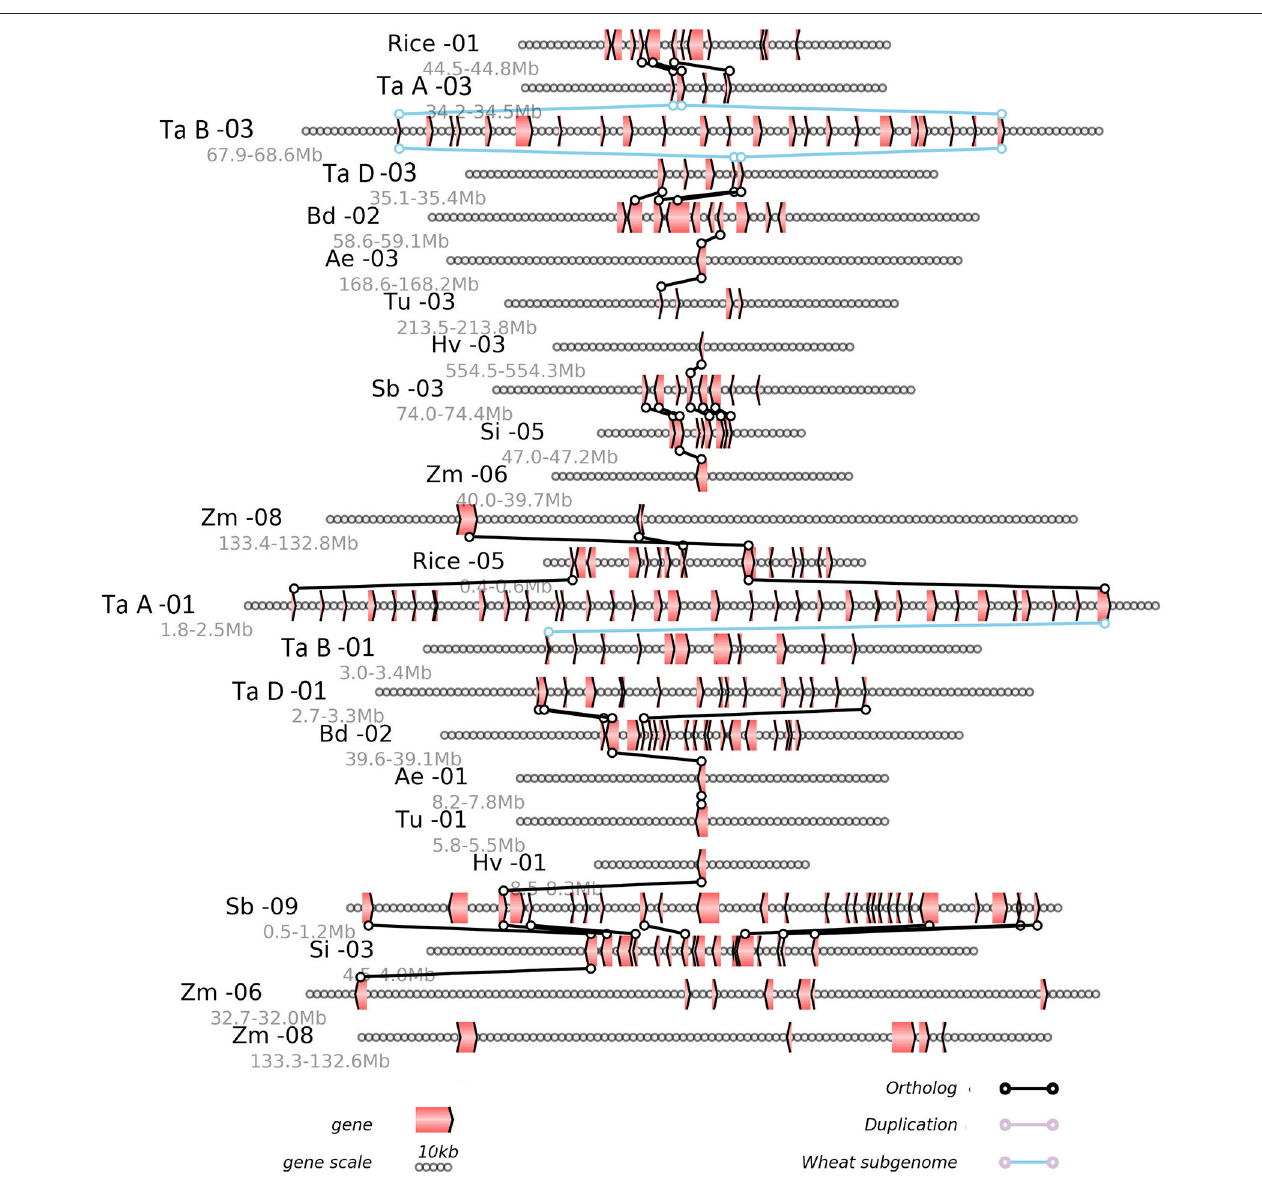
FIGURE 3 | Alignment of the local regions sharing homology. Ae, Aegilops tauschii; Bd, Brachypodium distachyon ; Si, Setaria italica; Hv, Hordeum vulgare ; Rice, Oryza sativa ; Sb, Sorghum bicolor ; Tu, Triticum urartu ; Zm, Zea mays ; Ta A, genome A of Triticum aestivum ; Ta B, genome B of Triticum aestivum ; Ta D, genome D of Triticum aestivum . Genes are shown with pointed boxes to indicate their transcriptional direction. Homologous genes between neighboring chromosomes (indicated by the straight lines) are linked to lines with circles at their